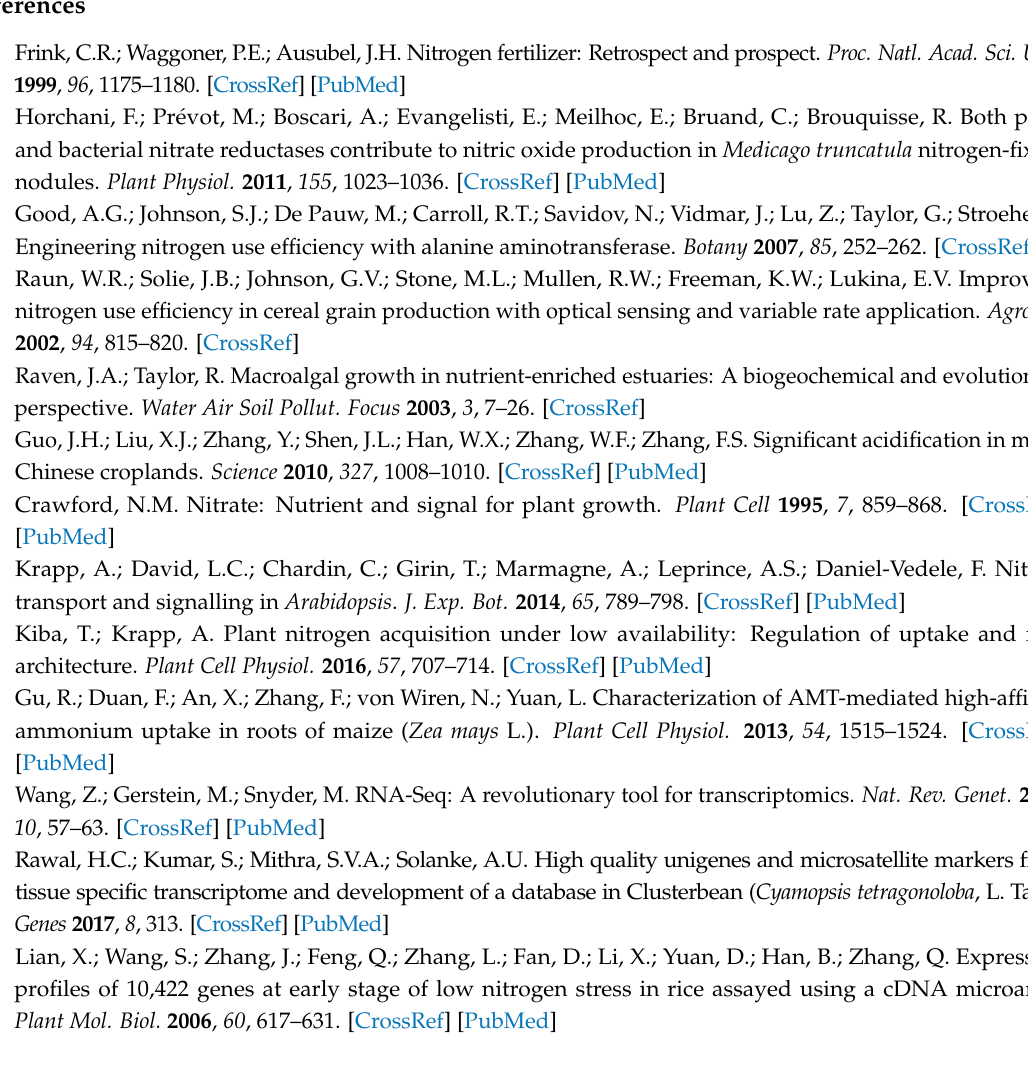
Supplementary Materials: The following are available online at http://www.mdpi.com/2073-4425/9/4/206/s1, Table S1: DEGs identified between optimal and low N from IR 64 and Nagina 22 root and shoot tissues, DEGs between the two genotypes in root and shoot tissues under optimal and low N, and nitrogen-responsive genes in root and shoot tissues, Table S2: The FPKM values of the genes encoding for enzymes involved in nitrogen and carbon assimilation in root and shoot tissues of two rice genotypes, Nagina 22 (N22) and IR64 under optimal (N+) and low N (N − ) supply, Table S3: Details of the primers and genes used for validation of the transcriptome results by q-PCR, Table S4: Go enrichment analysis results of the six comparisons made (DEGS from root and shoot tissues of IR64, N22 and IR64 vs. N22), Table S5: Nitrogen use efficiency QTLs known in rice and used for co-localization of N-responsive DEGs identified in the study, Table S6: Details of the DEGs co-localized with the NUE QTLs, Table S7: The FPKM values of the genes differentially expressed between the two rice genotypes, Nagina 22 (N22) and IR64 in root and shoot tissues under optimal (N+) and low N (N − )